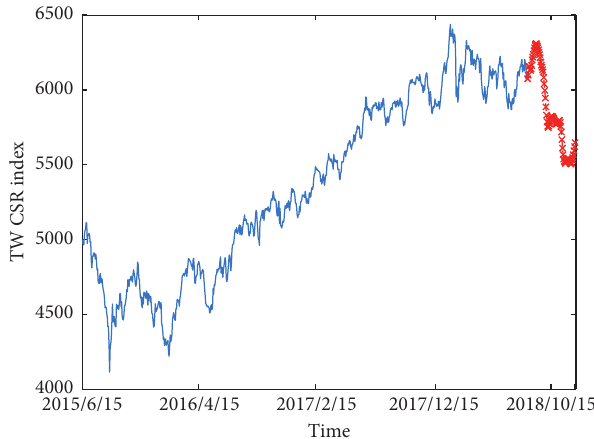
Figure 23: Addition of all prediction results for IMF1 to IMF6.